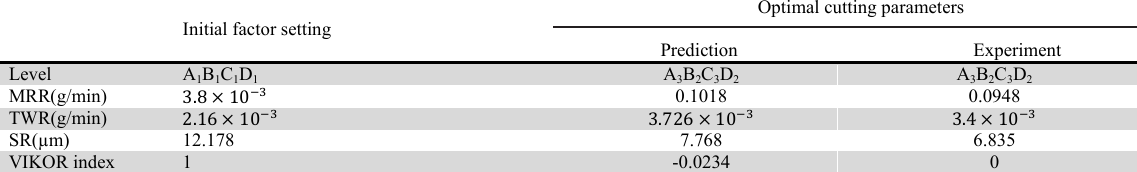
Results of the confirmatory experiment for VIKOR